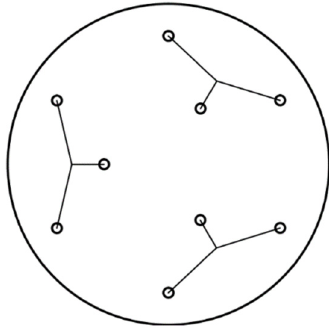
Figure 2. Schematic diagram of the connection of support units.